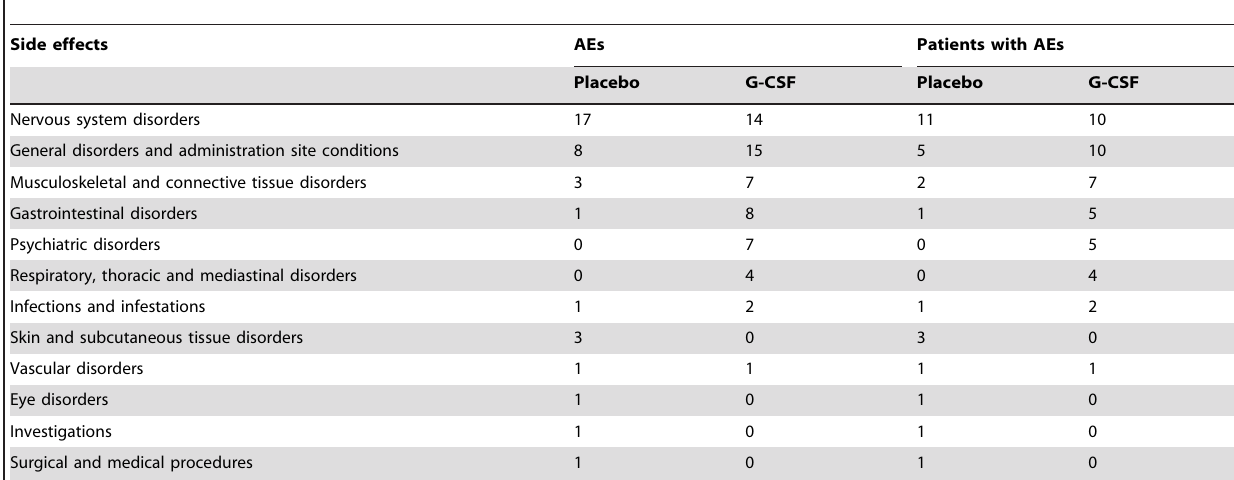
Table 2. All adverse events, listed by system organ class (n= 21 in the G-CSF, n =20 in the placebo group.